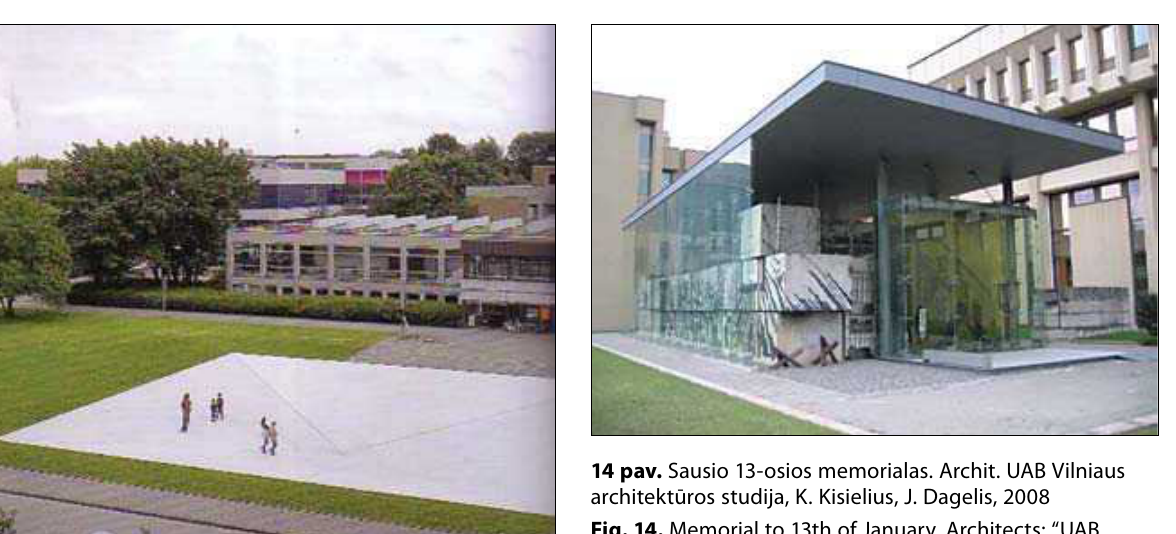
Fig. 14. Memorial to 13th of January. architects: “Uab Vilniaus architektūros studija”, k. kisielius, J.Dagelis, 2008